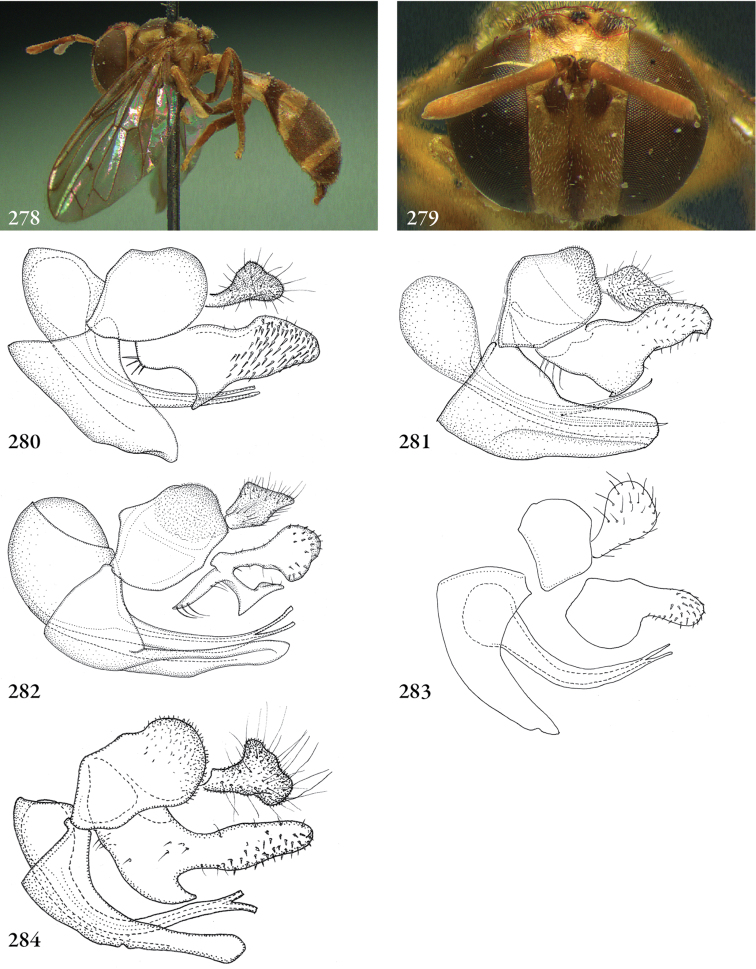
278–279
Paramixogaster vespiformis female (syntype): 278 habitus lateral 279 head frontal 280–284
Paramixogaster, male genitalia: 280
Paramixogaster acantholepidis (holotype) 281
Paramixogaster illucens (holotype) 282
Paramixogaster luxor (holotype) 283
Paramixogaster omeanus (Australia, coll. USNM) 284
Paramixogaster cf. vespiformis (Vietnam, coll. RMNH).